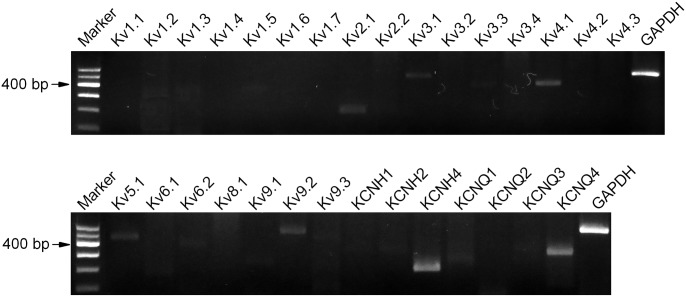
The mRNA expression of Kv channels.The PCR product of GAPDH (316 bp) at right lane was taken as positive control. N2A cells displayed bands for Kv2.1, Kv3.1, Kv4.1, Kv5.1, Kv9.2, KCNH4, and KCNQ4, corresponding to expected length shown in Table 1. The first lane showed the DNA maker.